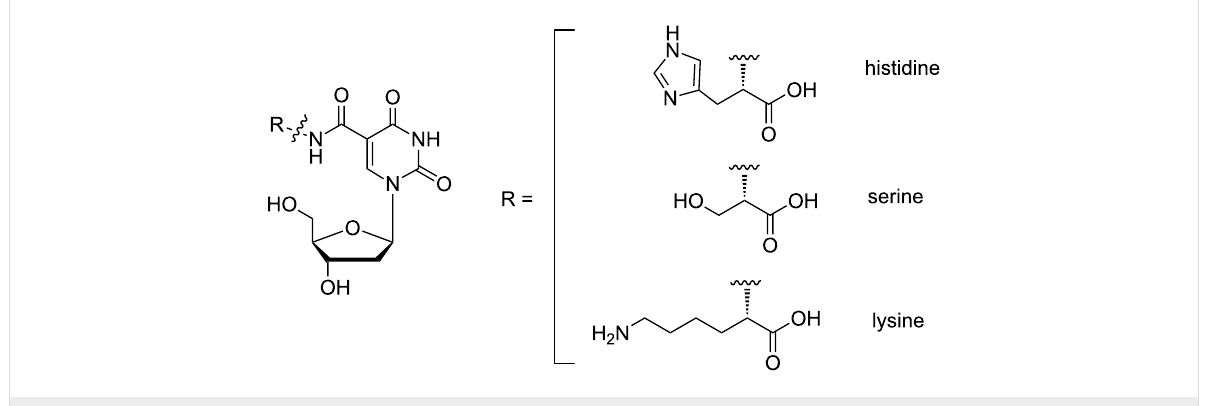
Figure 1: Amino acid functionalized